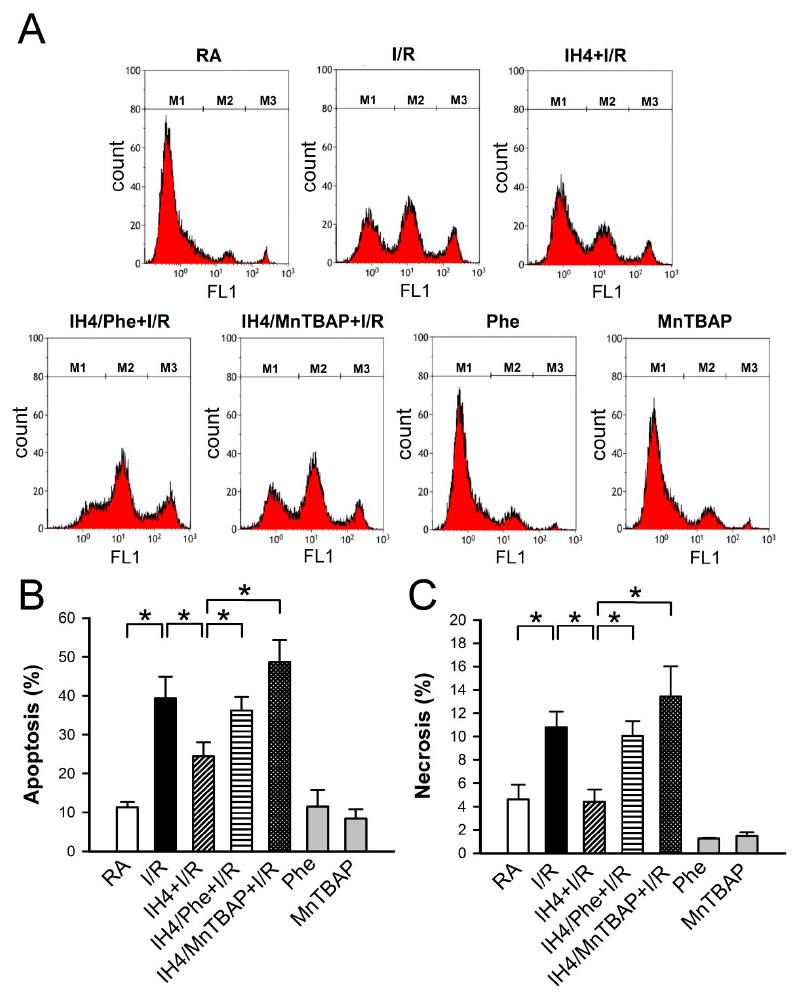
Figure 6. Effects of IH on the I/R-induced apoptosis and necrosis. ( A ) The representative plots show the flow cytometry analysis of Annexin V-FITC and SYTOX green florescence intensity in the cardiomyocytes treated with RA, IH4 and IH4 with an antioxidant, Phe or MnTBAP, followed by ischemia for 6 h and reperfusion for 12 h. M1, M2, and M3 represent the population of viable cells, apoptotic cells and necrotic cells, respectively. IH4 attenuated the I/R-induced apoptosis ( B ) and necrosis ( C ). IH4 with Phe or MnTBAP abolished the IH4-attenuated the I/R-induced apoptosis and necrosis.. Data represent the means ± SEM. RA: n = 10, RA + I/R: n = 6, IH4 + I/R: n = 5, IH4/Phe + I/R: n = 6, IH4/MnTBAP + I/R: n = 6, Phe: n = 4, MnTBAP: n = 4. * p < 0.05. I/R, ischemia/reperfusion; IH,